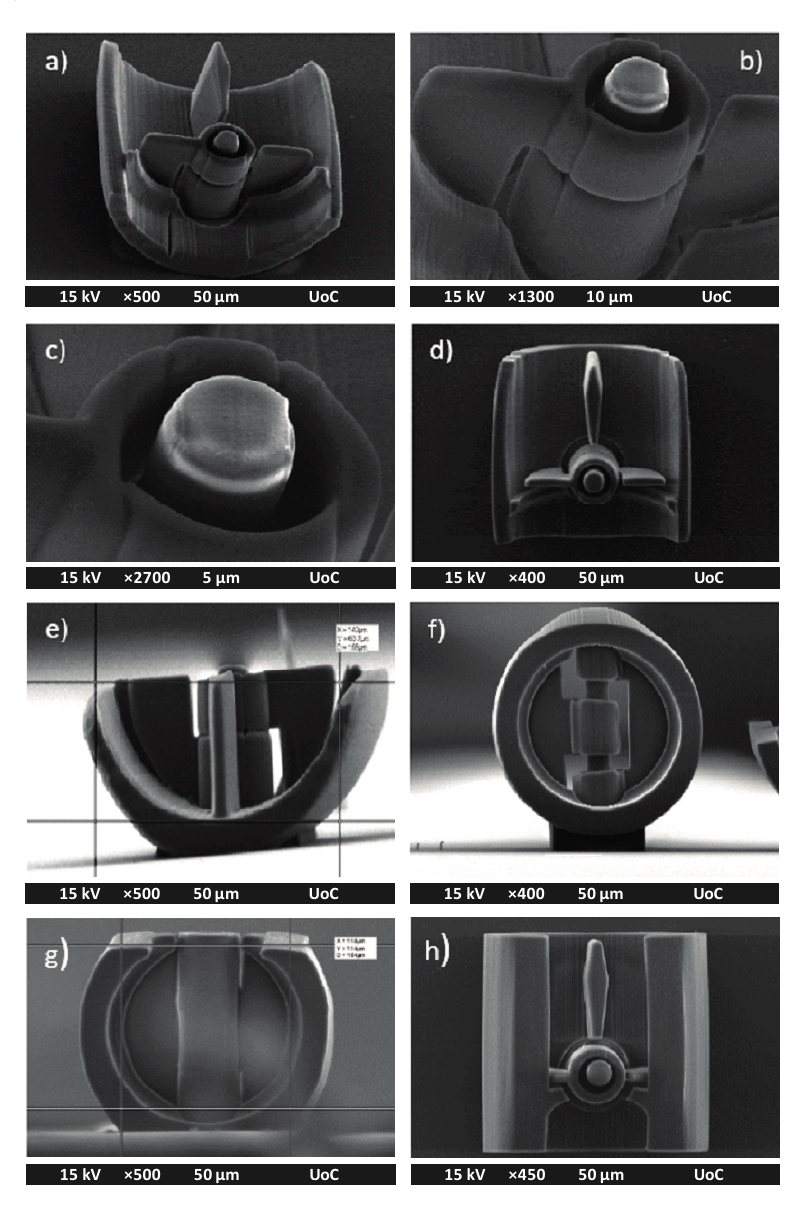
Figure 2. SEM images of the micro-valve fabricated using the laser writing